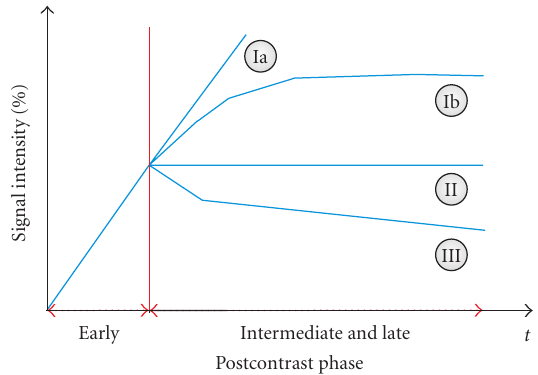
Figure 1: Schematic drawing of the time-signal intensity (SI) curve types [2]. Type I corresponds to a straight (Ia) or curved (Ib) line; enhancement continues over the entire dynamic study. Type II is a plateau curve with a sharp bend after the initial upstroke. Type III is a washout time course. The initial contrast enhancement sa i is given by (4). In breast cancers, plateau or washout-time courses (type II or III) prevail. Steadily progressive signal intensity time courses (type I) are exhibited by benign enhancing